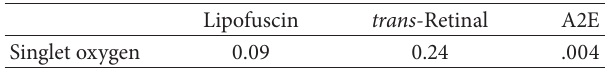
Table 2: Quantum yields for singlet oxygen for retinal chro-